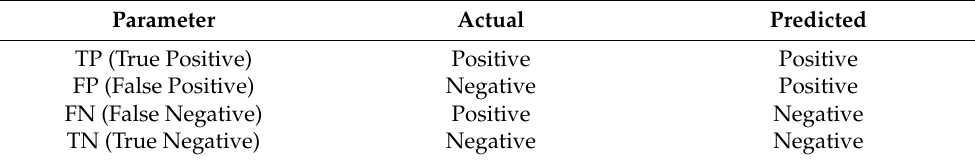
Table 2. Parameters used to quantify the correctness of the model output.